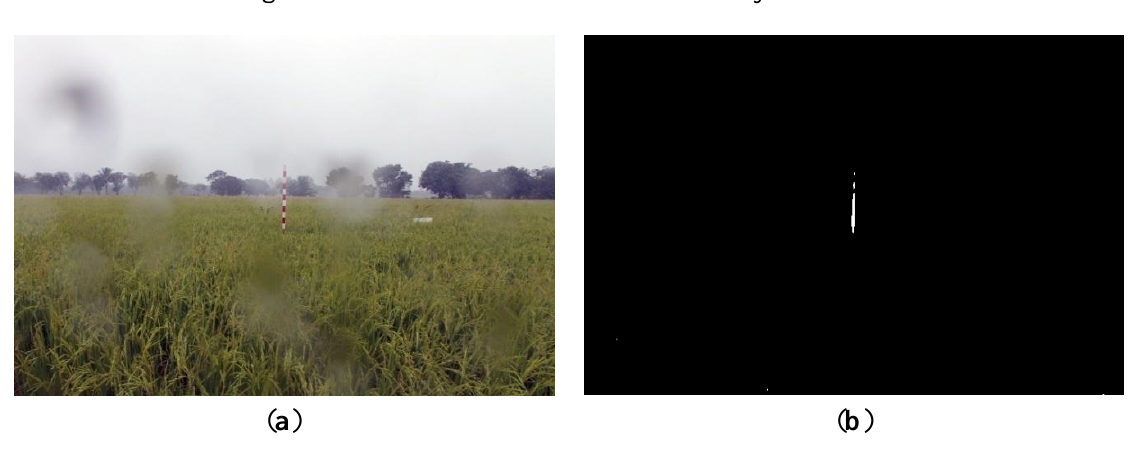
Figure 22. Comparison between ( a ) RGB and ( b ) resultant binary images using proposed method with excess green feature in case of rainfall on 25 July 2012.